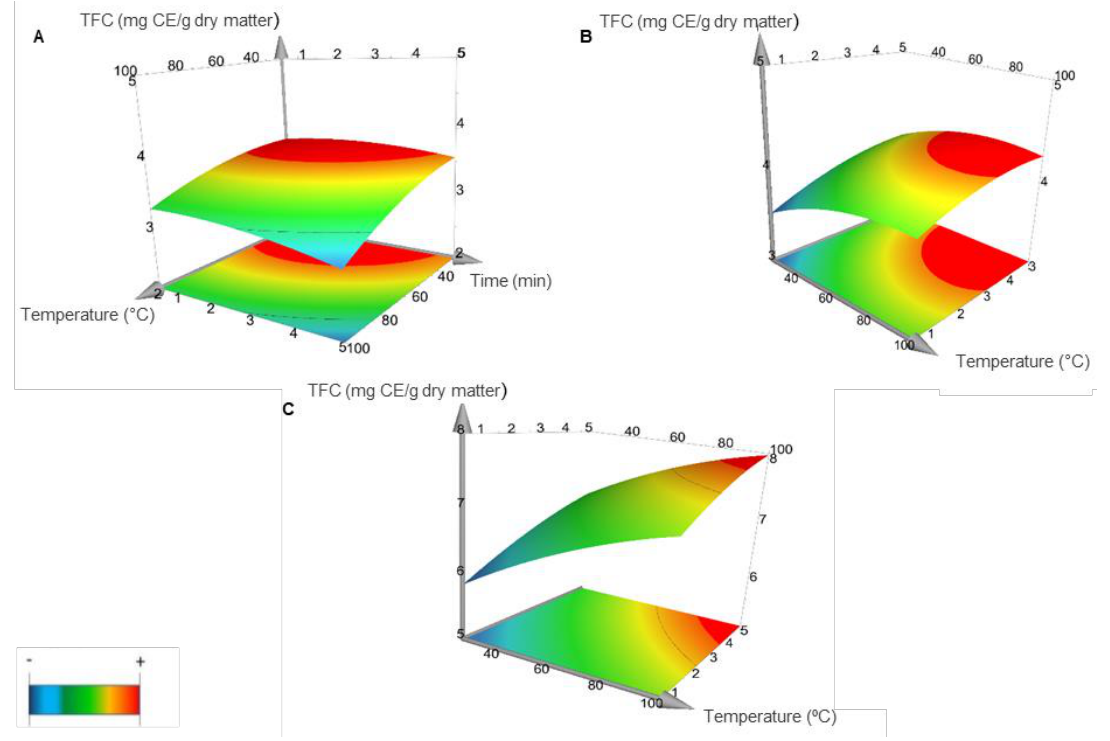
Figure 2. Response surface plot representing the effects of time, temperature and solvent ratio on Total Flavonoids Content (TFC) from saffron floral by-products. ( A ) Ethanol concentration was kept constant at 0%. ( B ) Ethanol concentration was kept constant at 50%. ( C ) Ethanol concentration was kept constant at 100%. Lower values are represented in blue and higher values in red.